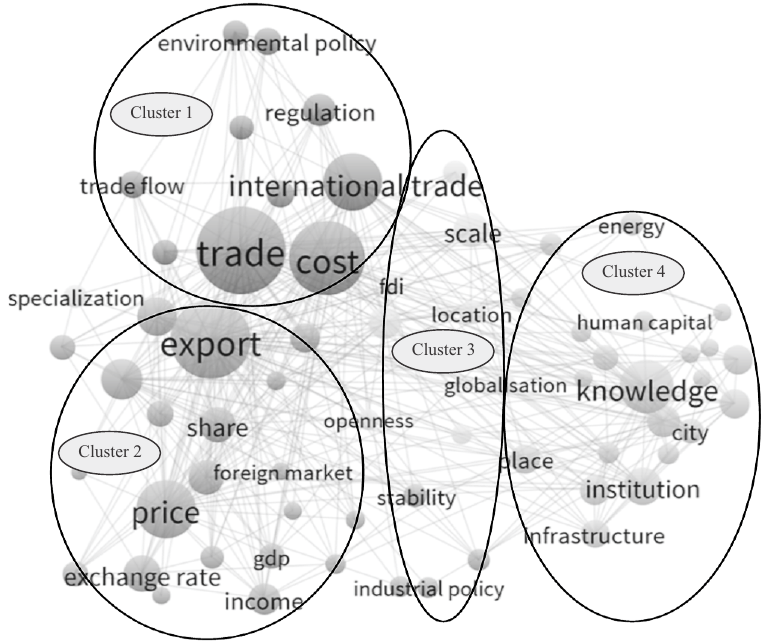
Fig. 4. Four clusters in the international competitiveness literature (1945–2015) by term co-occurrence analysis Source: Own calculation on Vosviewer